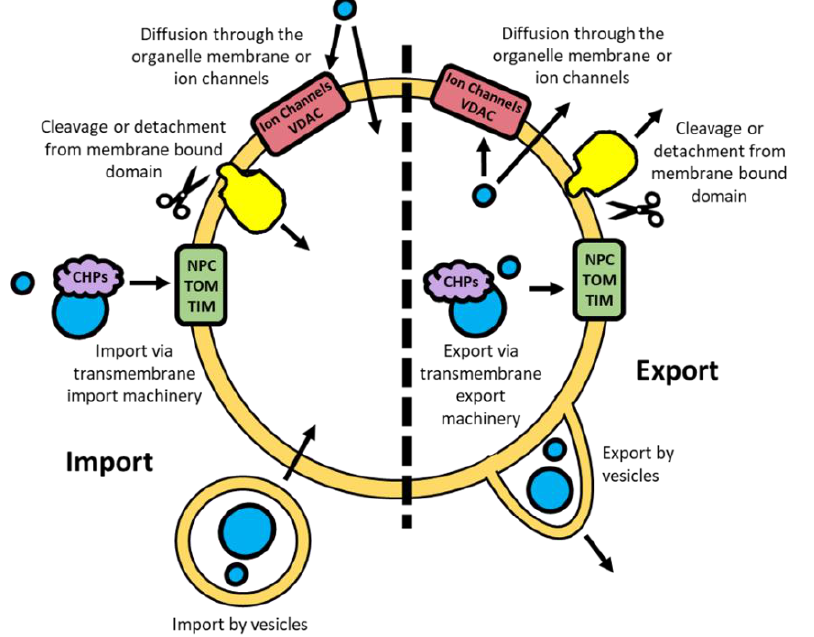
Figure 3. Import and export mechanisms for molecules passing through an intracellular nuclear or mitochondrial double membrane. NPC; nuclear pore complex. TOM; translocase of the outer membrane. TIM; translocase of the inner membrane. VDAC; voltage-dependent anion channel. CHPs; chaperones.